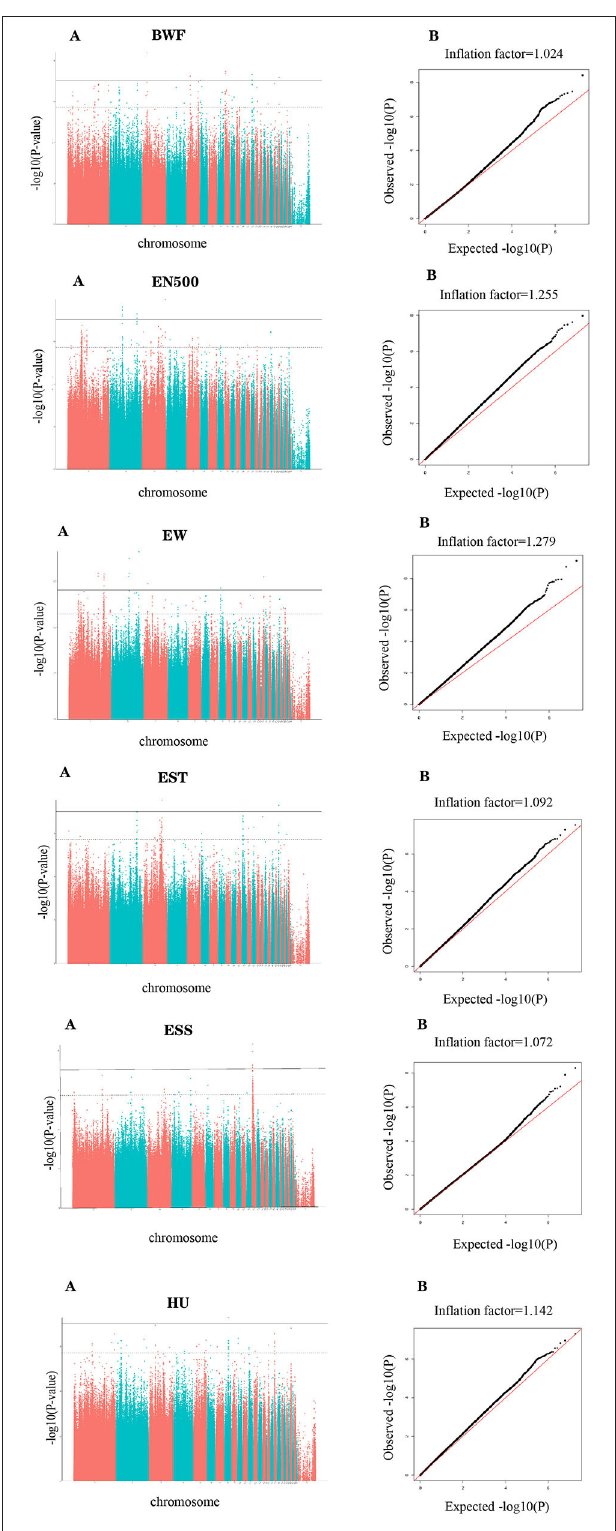
FIGURE 1 | Manhattan (A) and Q-Q plots (B) were derived from GWAS for body weight at first oviposition (BWF), number of eggs produced in 500 days (EN500), Egg weight (EW), egg shell thickness (EST), egg shell strength (ESS),